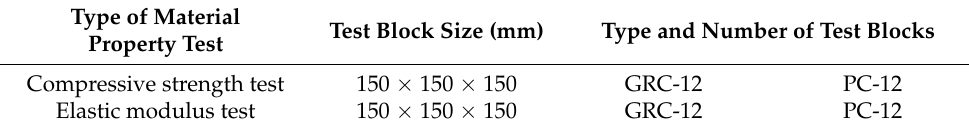
Table 2. Parameters of material test block.